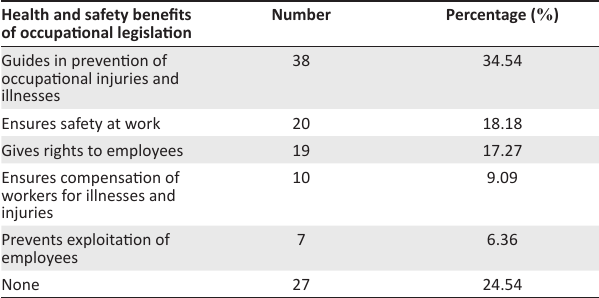
TABLE 2: Health and safety benefits of occupational legislation for workers as indicated by respondents ( n = 110). Health and safety benefits of occupational